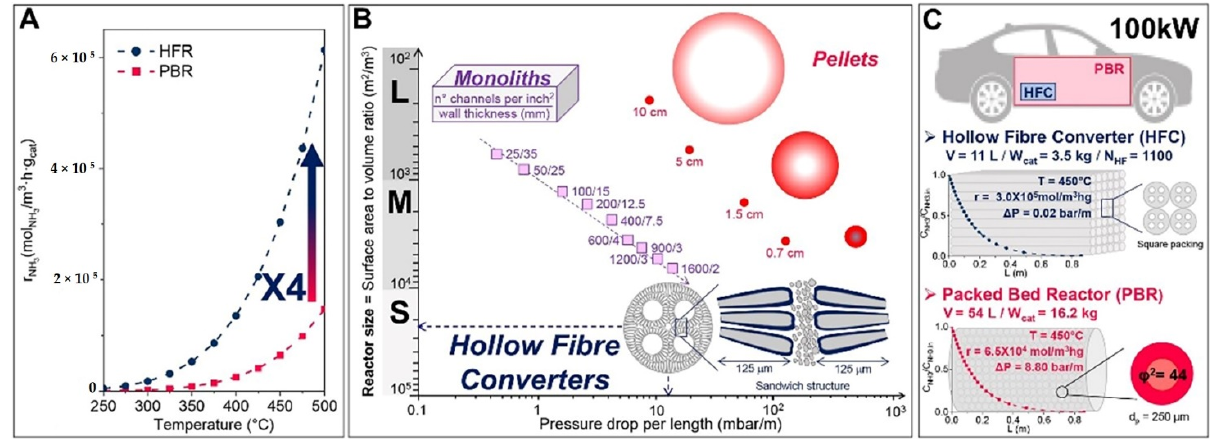
Figure 23. ( A ) Compression of the fixed bed PBR and the HFR decomposition rate by temperature, ( B ) the size of reactors and their pressure drop per length, ( C ) designed reactor for 72 m 3 /h H 2 supply of a 100 kW car. Reprinted with permission [41,110].